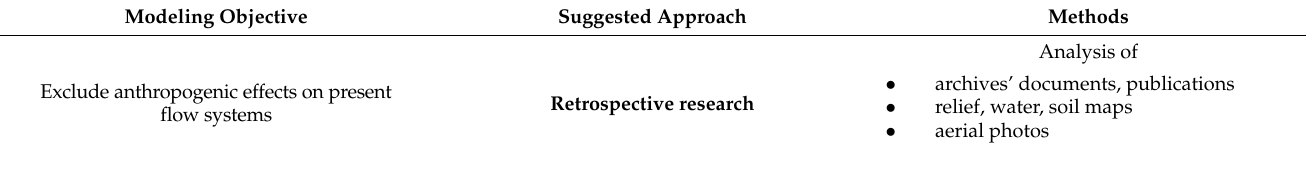
Table 2. Objective, approaches and methods of basin-scale groundwater flow system evaluation.